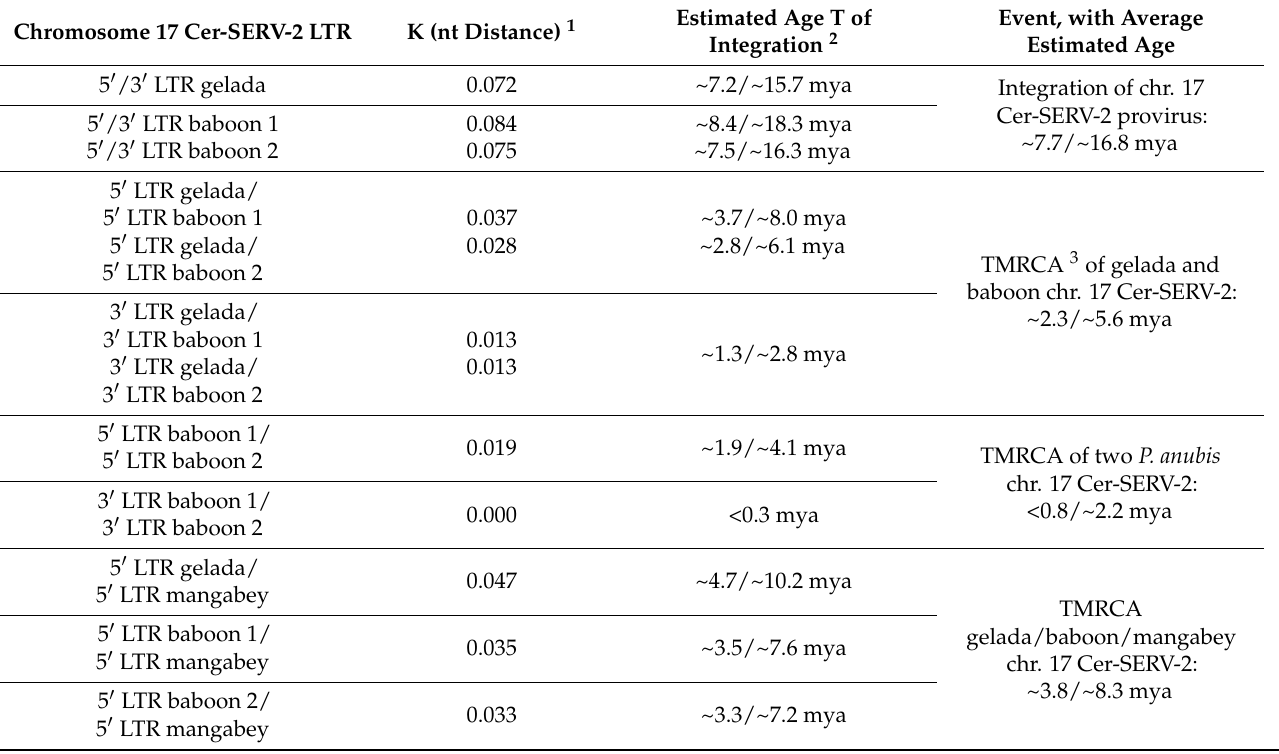
Table 3. Average age estimation based on LTR divergence of the chromosome 17 full-length Cer - SERV-2 integration in Papio (baboon 1, baboon 2), Theropithecus (gelada) and Cercocebus